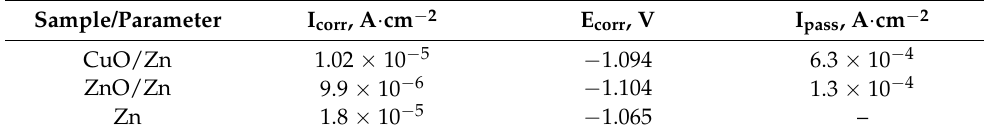
Table 1. Some important electrochemical parameters obtained from the potentiodynamic polarization measurements (the presented values refer to a representative curve selected from investigations performed with a group of samples of a given species).